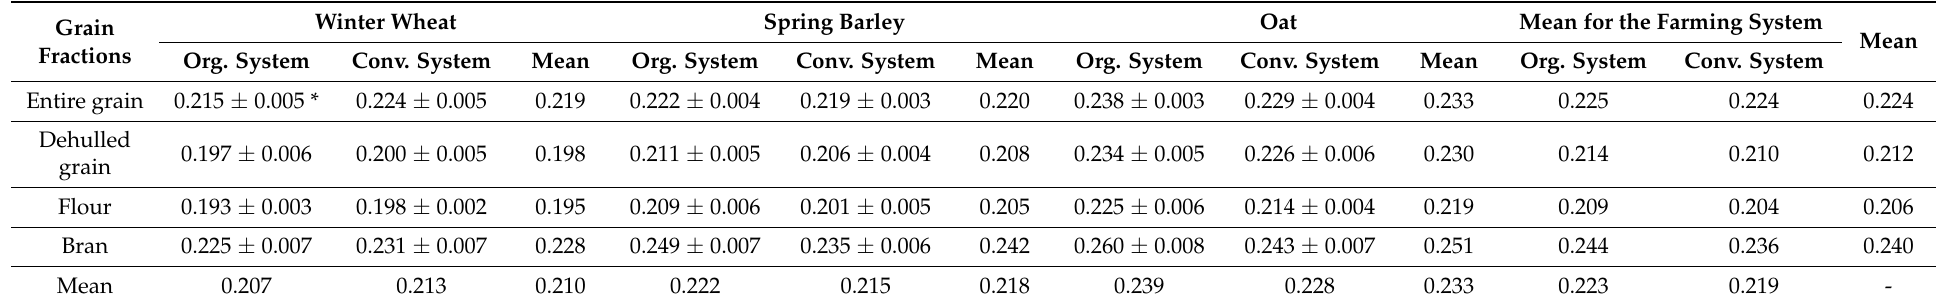
Table 2. Effect of cereal grain milling on grain absorbance (%) (FRAP method)—2017–2019